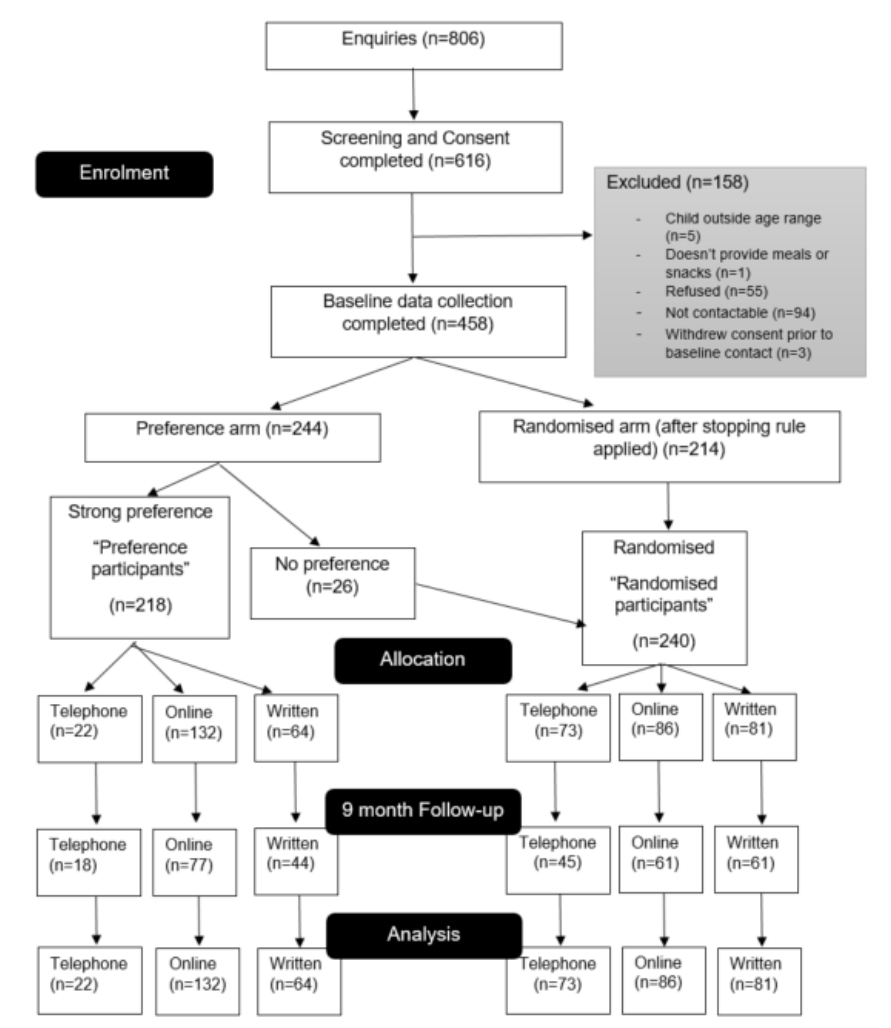
Figure 1. CONSORT flow diagram [32]. Table 3. Changes in parent consumption of vegetables (mean daily